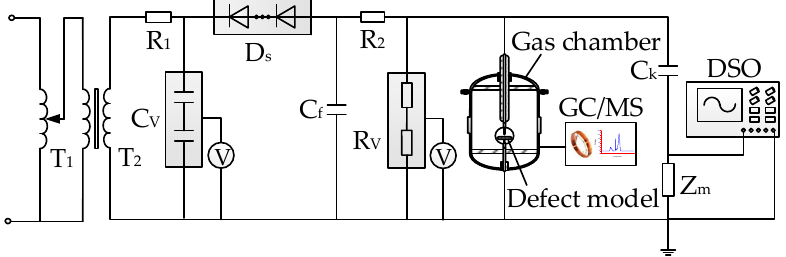
Figure 1. Experimental wiring of SF 6 decomposition under negative DC-PD.